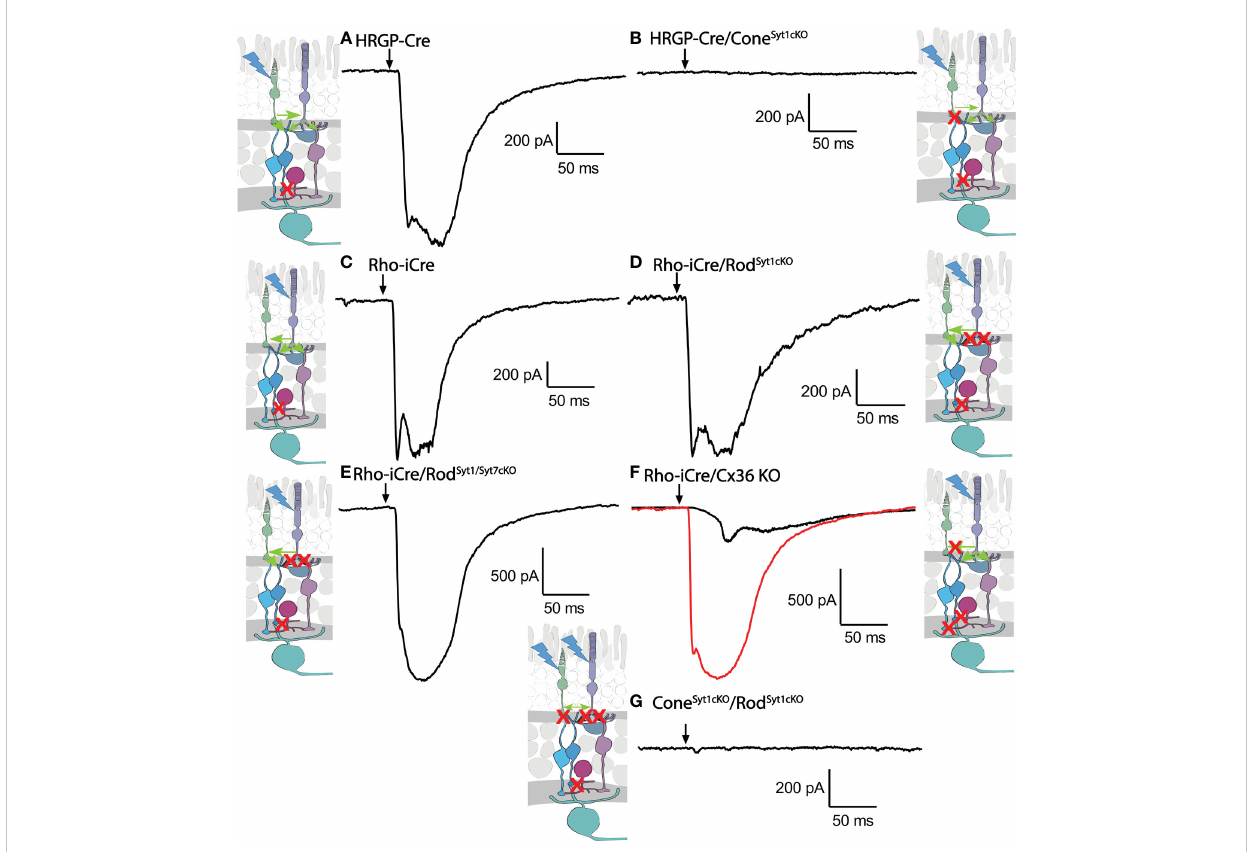
FIGURE 7 Example waveforms of responses evoked by optogenetic stimulation of rods and/or cones lacking Syt1, Syt7, or Cx36. (A) Current evoked by optogenetic stimulation of cones in an a RGC. Red X in the diagram represents blockade of glycinergic synapses from AII amacrine cells to cone OFF bipolar cells by strychnine. (B) Response to optogenetic stimulation of cones was abolished by the absence of Syt1 from cones. (C) Example current evoked by optogenetic stimulation of rods. (D) Response to optogenetic stimulation of rods was remained in the absence of Syt1 from rods. (E) Response to optogenetic stimulation of rods also remained in the absence of both Syt1 and Syt7 from rods. (F) Two example responses to optogenetic stimulation of rods in Cx36KO mice. Black trace shows the typical slow response that was observed in most cells. The red trace shows the large fast response observed in one OFF cell. (G) Response to optogenetic stimulation of rods and cones was abolished by the absence of Syt1 from both rods and cones. Experiments in this fi gure were conducted in the presence of strychnine (1 m M) and picrotoxin (100 m